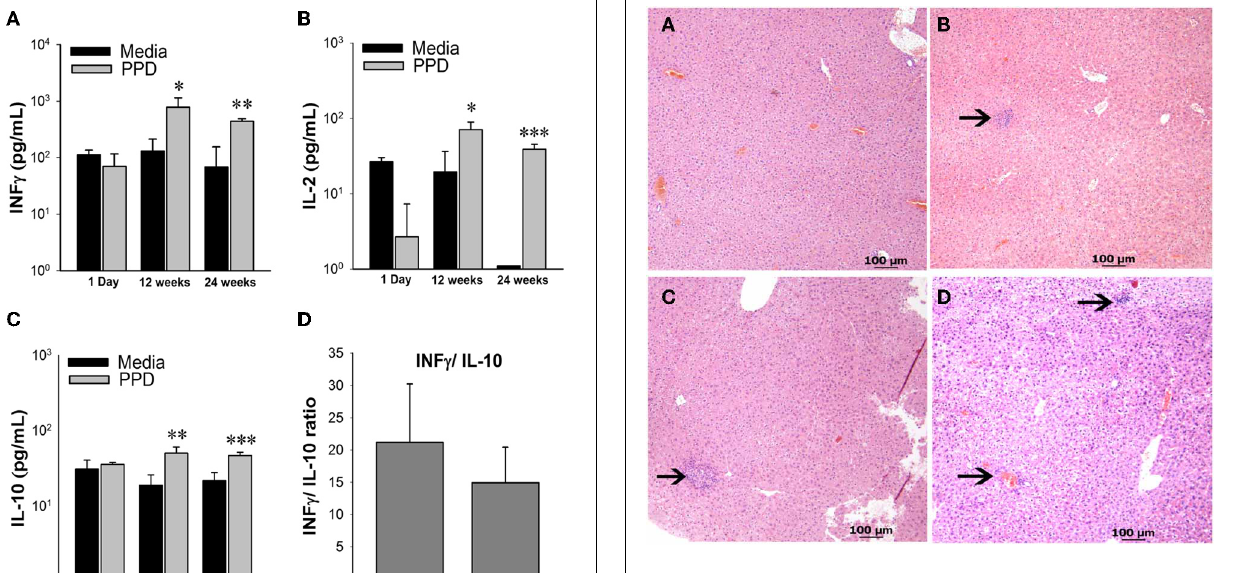
FIGURE 4 | Liver pathology from high dose oral M. avium subsp. paratuberculosis K10 challenge at various time points. Images (A–D) reveal liver pathology from mice orally infected with two consecutive doses of 10 9 CFU of M. avium subsp. paratuberculosis K10 over a 24 week period. H&E stained sections with 40 × magnification (scale bar = 100 μ m) are shown. Images of 6 and 12 weeks post infection show lymphocyte inflammation and the image at 24 weeks post infection shows granulomatous inflammation. (A) Non-infected (B) 6 weeks (C) 12 weeks (D) 24